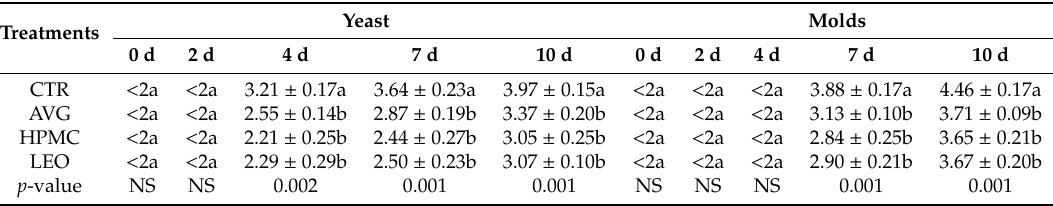
Table 3. Yeast and mold loads of fruit